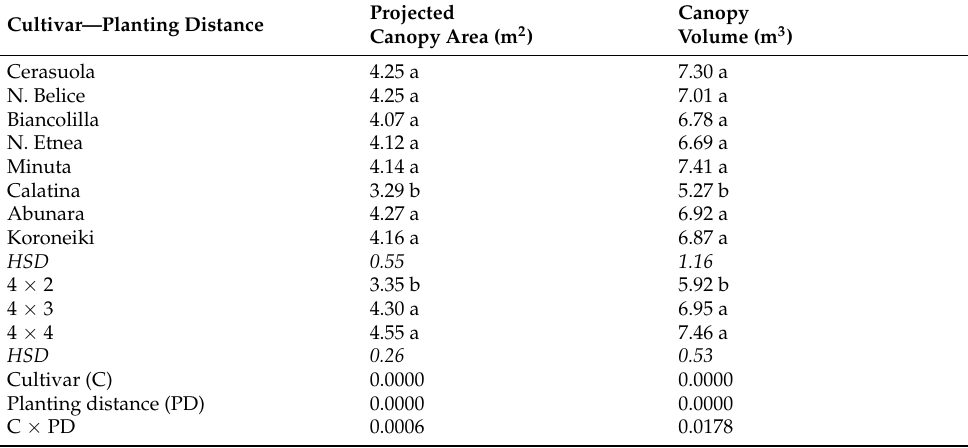
Figure 2. Relationship between the ground measured and UAV-estimated canopy volume (CV) of olive trees of different cultivars (Biancolilla, Calatina and Koroneiki) planted at the 4 × 2 m (black symbols), 4 × 3 m (grey symbols) and 4 × 4 m (white symbols). Each symbol represent one tree. Equation: Esimated CV = 0.85 measured CV + 0.45, R 2 = 0.82, RMSE = 0.68, MAPE = 9.25. Table 2. Projected canopy area and canopy volume of different olive tree cultivars planted at 4 × 2, 4 × 3 and 4 × 4 m. Values are means of 30 (cultivar) and 80 (planting distance) trees. Different letters indicate significant differences between cultivars (main plot) and planting distances (sub-plot) after analysis of variance (ANOVA). Legend: HSD, honestly significant